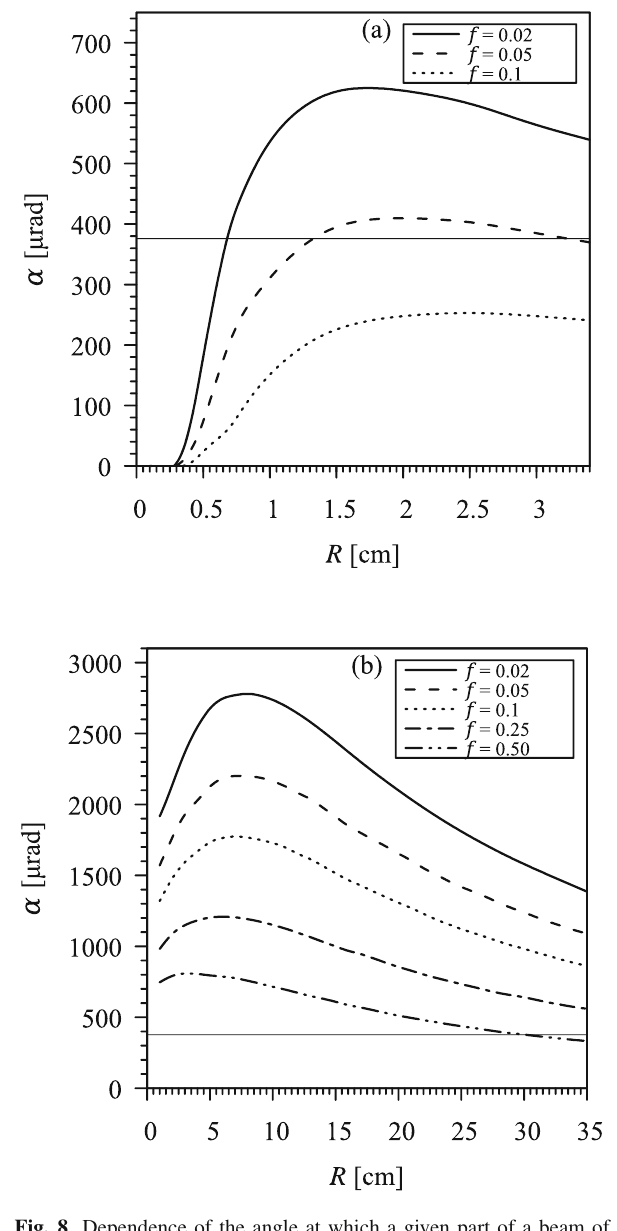
Fig. 8 Dependence of the angle at which a given part of a beam of antiprotons with a kinetic energy of 1 GeV can be deflected by means of planar channeling ( a ) and stochastic deflection ( b